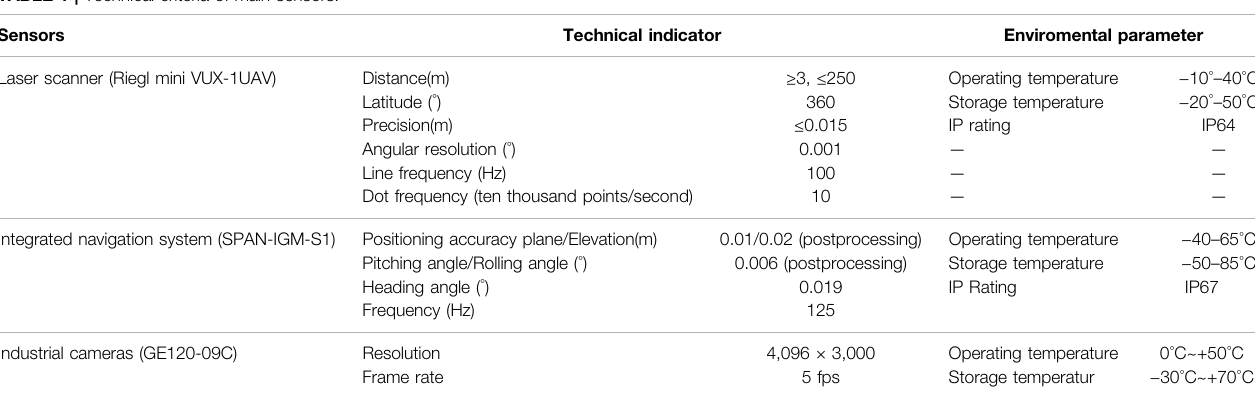
TABLE 1 | Technical criteria of main